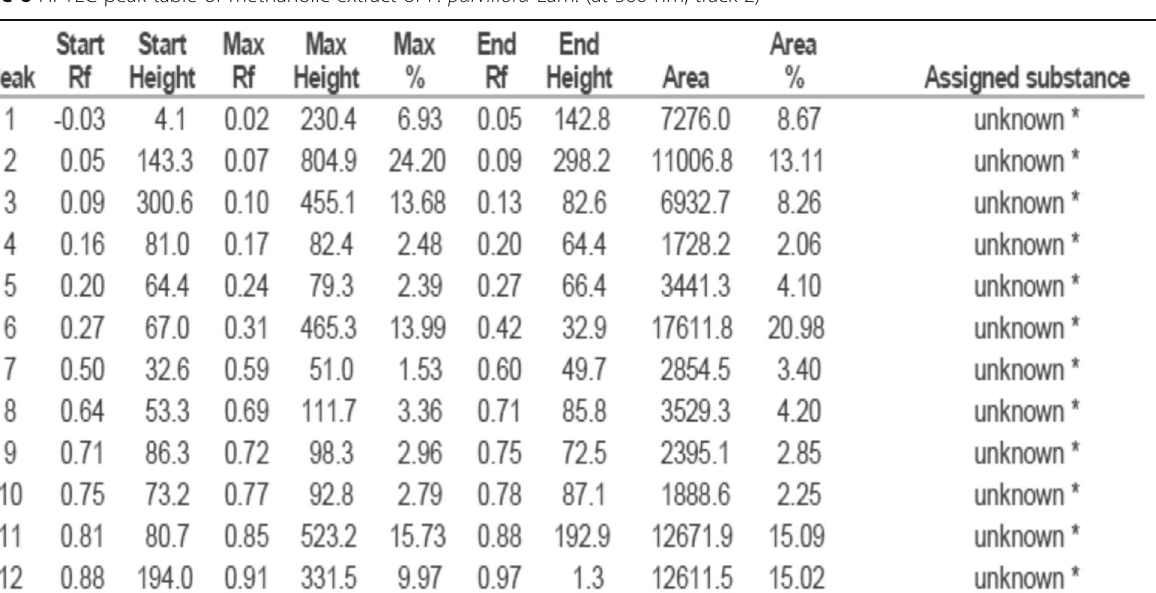
Table 6 HPTLC peak table of methanolic extract of F. parviflora Lam. (at 366 nm, track